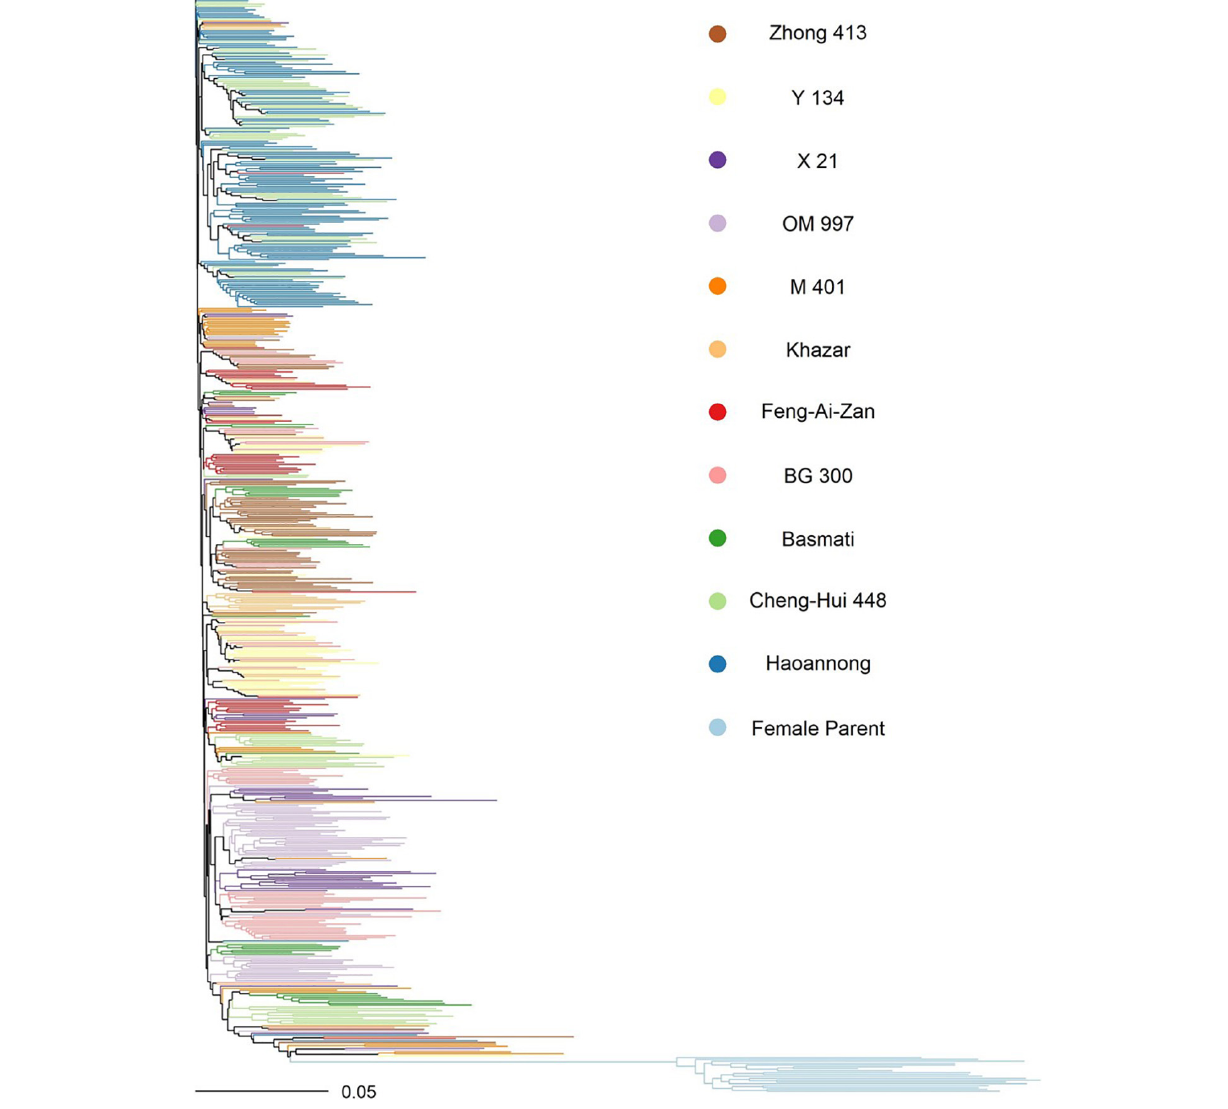
FIGURE 1 | Neighbor-joining tree of the parental lines used in the study. Color indicates the female parents (light blue) and, for the male parents, their subfamily by donor parent (all other colors). The recurrent parent for all males was